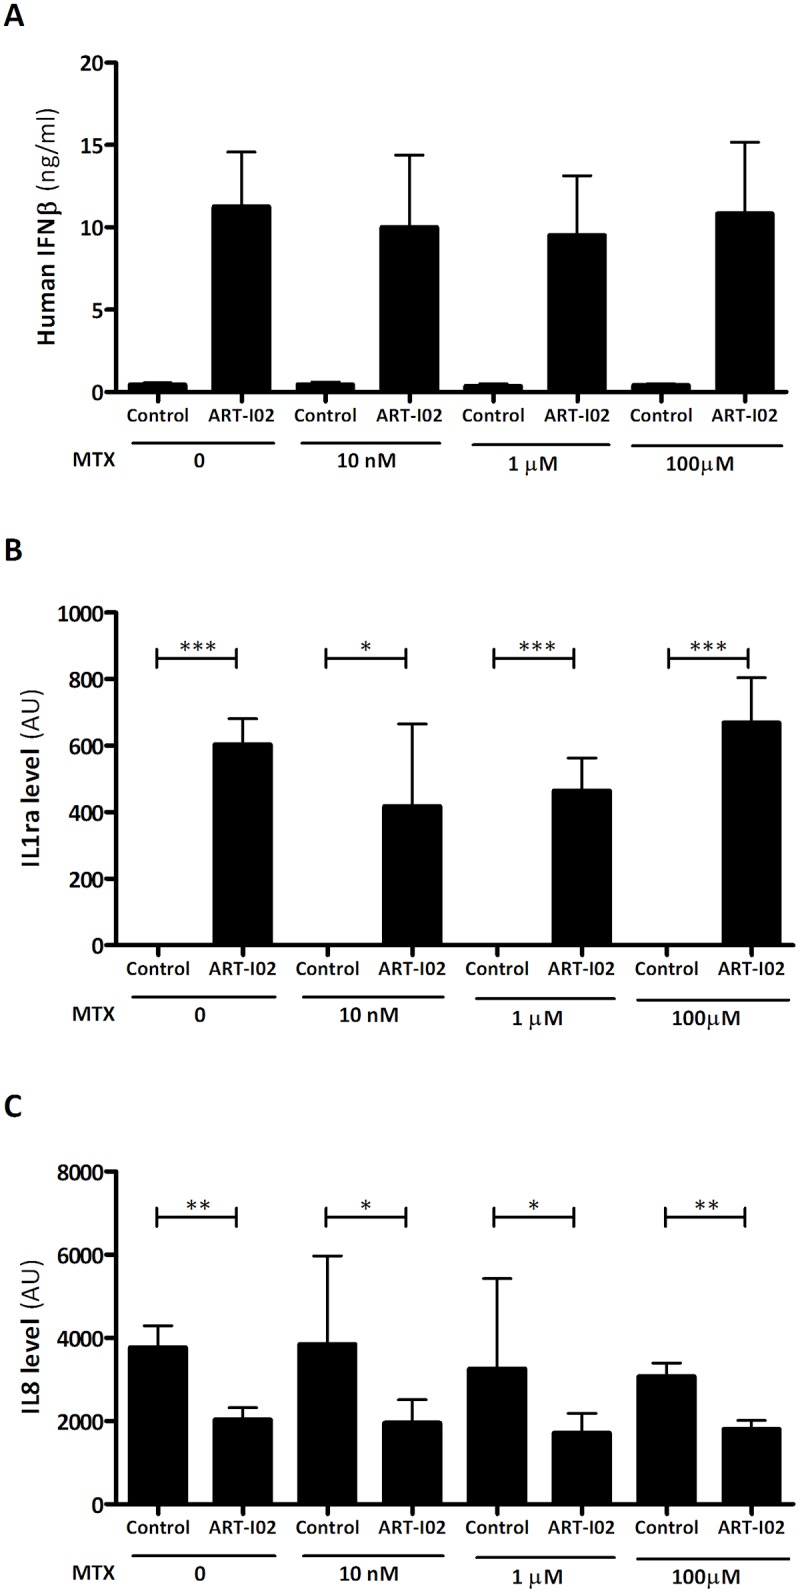
Effect of MTX on transgene expression and bioactivity in RA FLS.In the presence of MTX hIFN-β transgene expression (A) and bioactivity shown by change in IL-1ra (B) and IL-8 (C) remained unaltered in RA FLS. All samples were stimulated with TNF-α. Control cells were stimulated but not transduced with ART-I02. Data shown are mean + SEM (hIFN-β) and mean + SD (cytokines), N = 3–6 experiments, * indicates P<0.05, ** P<0.01 and *** P<0.001.